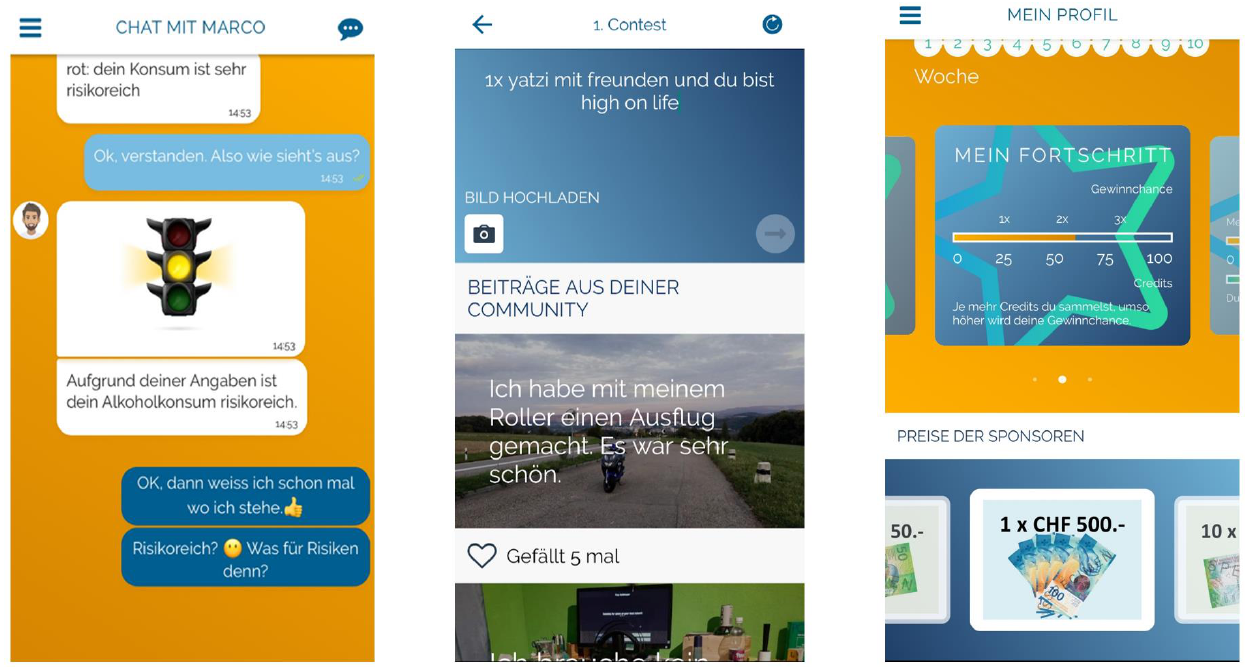
Figure 2. Screenshots from the MobileCoach Alcohol program (left: feedback on alcohol use; middle: contest on beautiful experience without alcohol; right: individual profile displaying progress within the program and potential prizes).